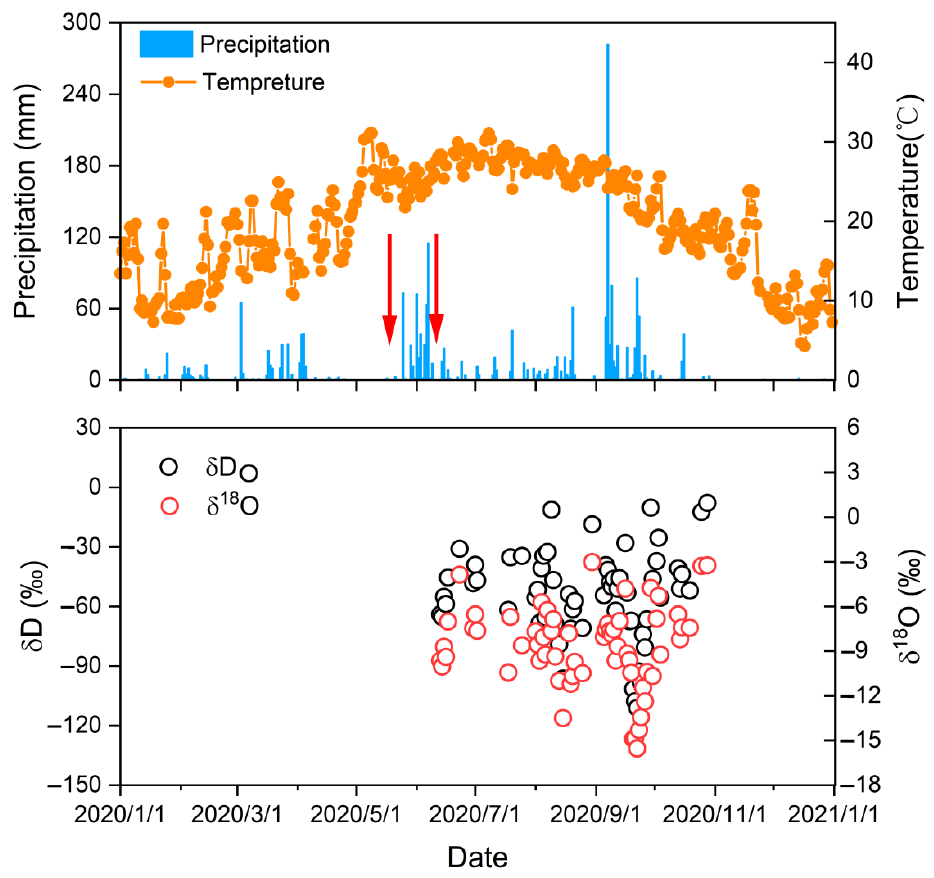
Figure 2. Variations in precipitation, mean air temperature, and isotopic values ( δ D, δ 18 O) in pre- cipitation at a daily timescale in 2020. Arrows indicate sampling dates. (The isotopic values of precipitation were not collected from January to April due to the COVID-19 pandemic impacting).